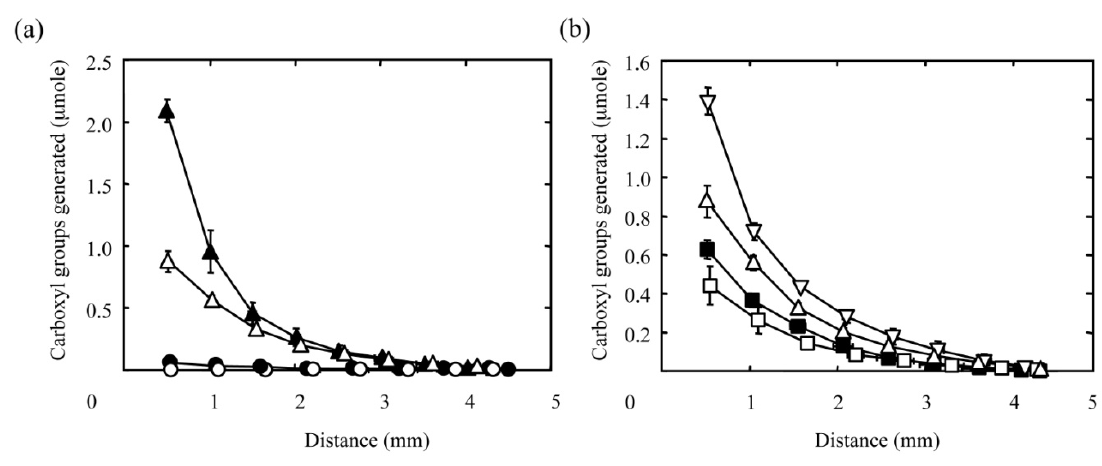
Figure 3. Effect of the NaOH concentration (a) and reaction time (b) on the amount of carboxyl groups generated in PAAm hydrogels by the hydrolysis of amide groups with NaOH solution. (a) The concentration of the NaOH solution is 0.001 ( ), 0.01 ( ), 0.1 ( ), or 1 M ( ). The reaction time is 30 min. (b) The reaction time is 10 ( ), 20 ( ), 30( ), or 60 min ( ). The concentration of the NaOH solution is 0.1 M. The X-axis indicates the distance from the surface of hydrogel facing the NaOH